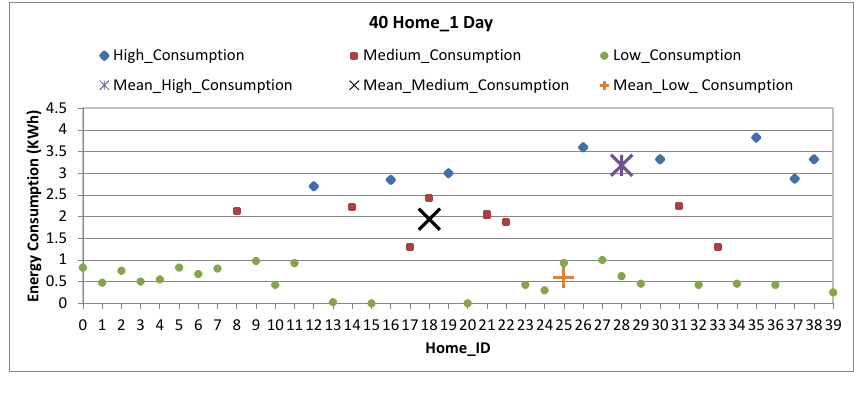
Figure 7. Results of one day cluster data analysis.